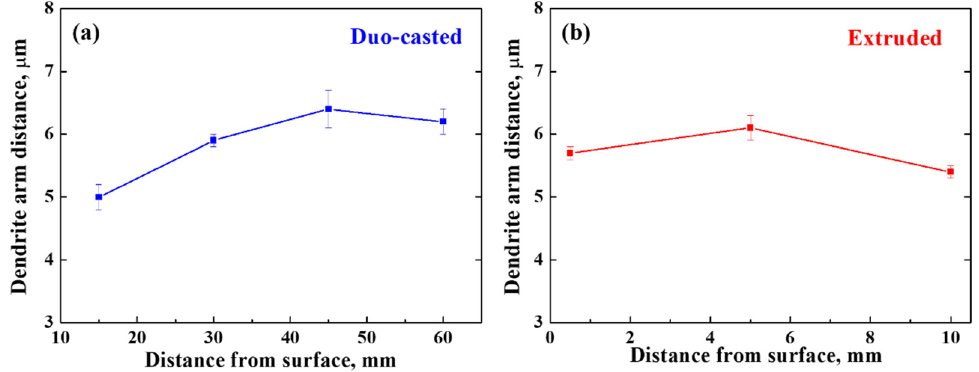
Figure 7. Distribution of dendrite arm distance for ( a ) duo-casted and ( b ) extruded Al3003 / Al4004 clad material.